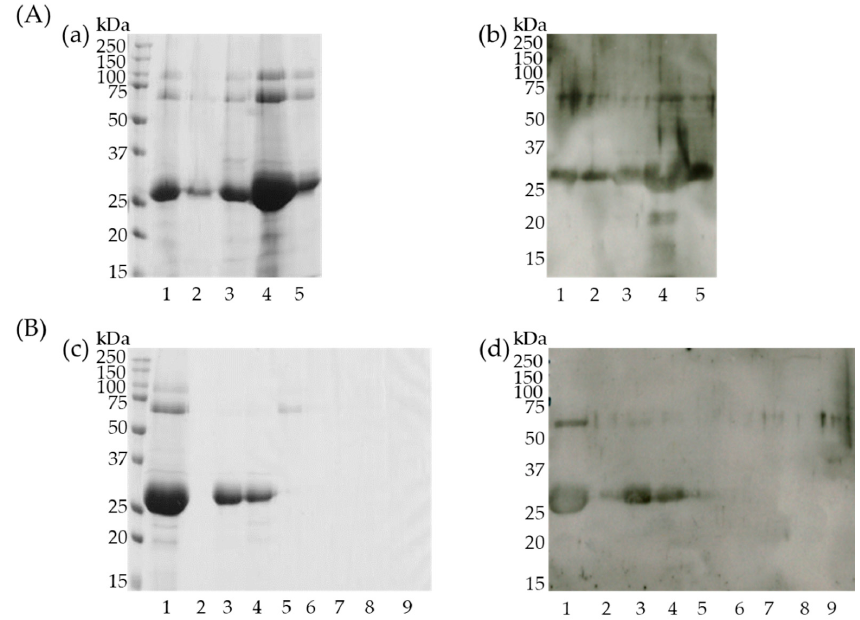
Figure 4. Fractionation of cherry proteins using ammonium sulfate precipitation ( A ) and ion-exchange chromatography ( B ). ( a , c ) Coomassie brilliant blue staining of fractionated cherry proteins. ( b , d ) Immunoblotting using fractionated cherry proteins, mixed mice sera, and HRP-labeled antimouse IgG1 antibody. ( A ) Lane 1, crude extracted sample; lanes 2~5, fractionated samples with 0–20% (2), 20–40% (3), 40–60% (4) and 60–80% (5) of ammonium sulfate precipitations. ( B ) Lane 1, fractionated sample with 40–60% ammonium sulfate precipitation; lane 2, flow-through fraction from ion-exchange chromatography; lanes 3~9, sample eluted with buffer A containing 0.05 M (3), 0.1 M (4), 0.2 M (5), 0.3 M (6), 0.4 M (7), 0.5 M (8), and 1 M (9) of